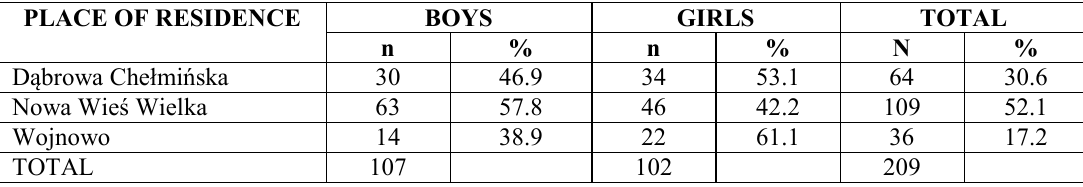
Statistical description of the children involved in the